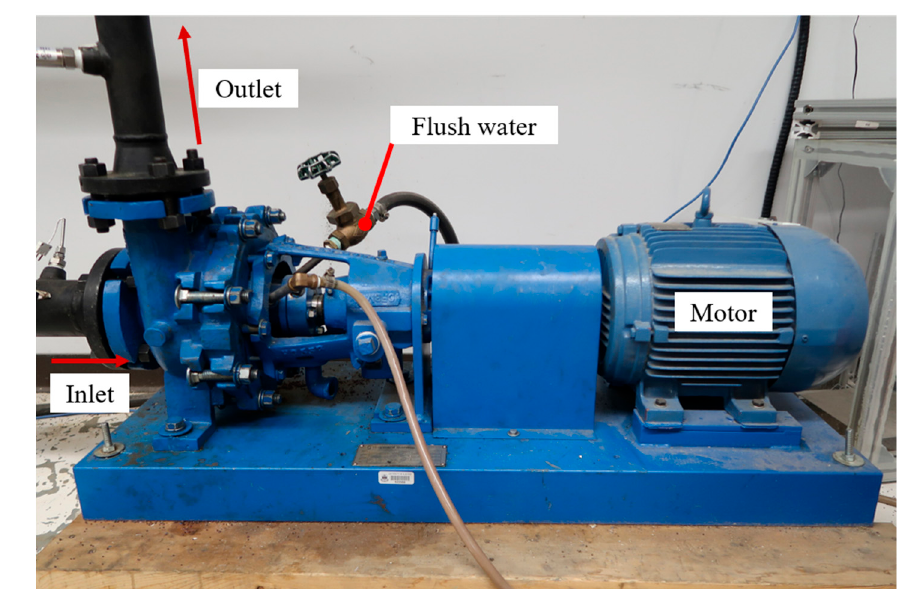
Figure 2. Test pump (From Hayward–Gordon Company).